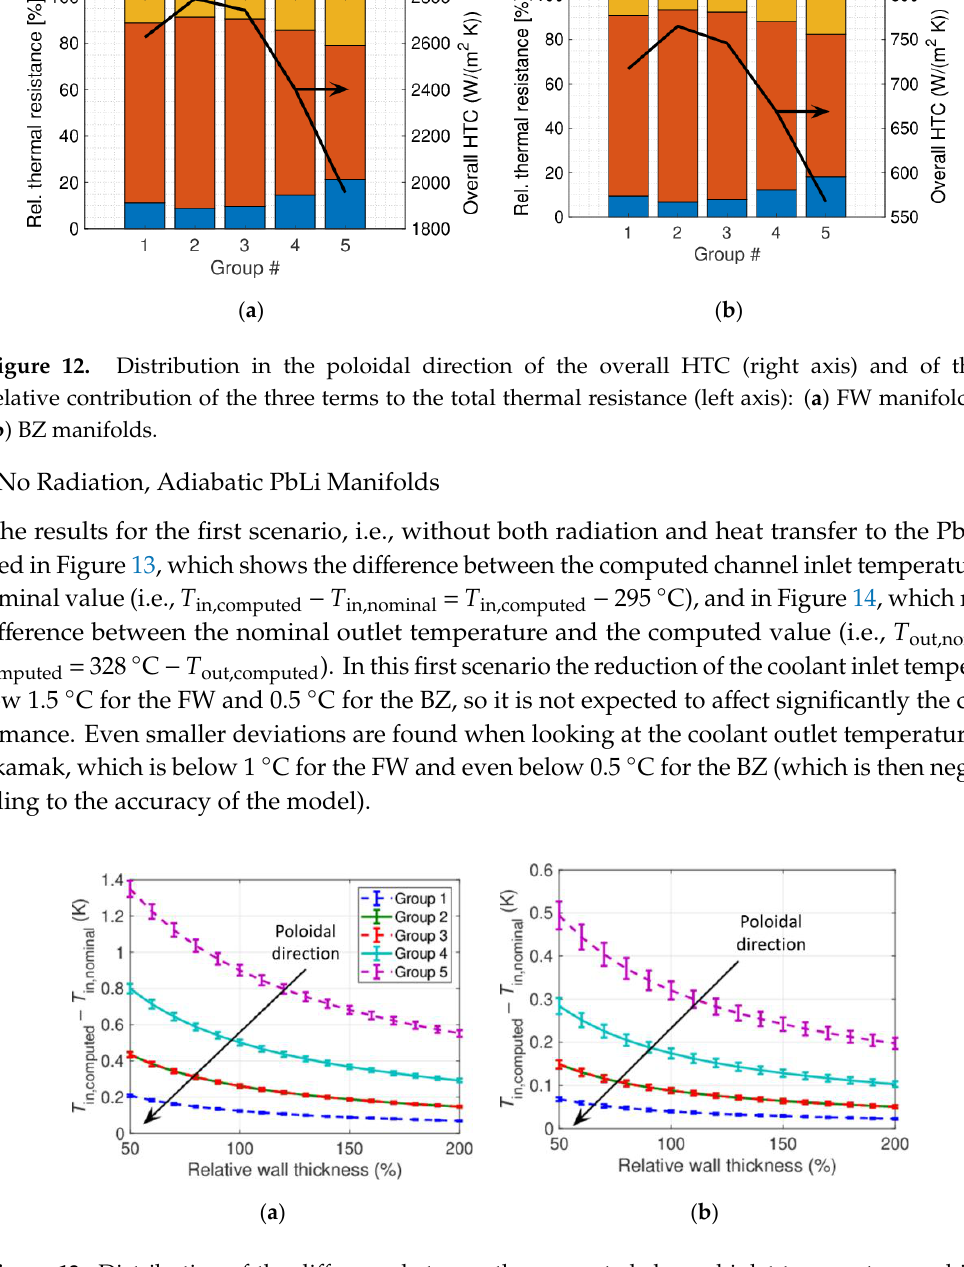
Figure 13. Distribution of the difference between the computed channel inlet temperature and its design value (295 °C), as a function of the wall thickness, for the case with no radiation and adiabatic PbLi manifolds: ( a ) FW manifolds; ( b ) BZ manifolds. Different lines represent different groups of channels in the poloidal direction, according to the lumping strategy (see Section 2 above and the nomenclature in Figure 6).